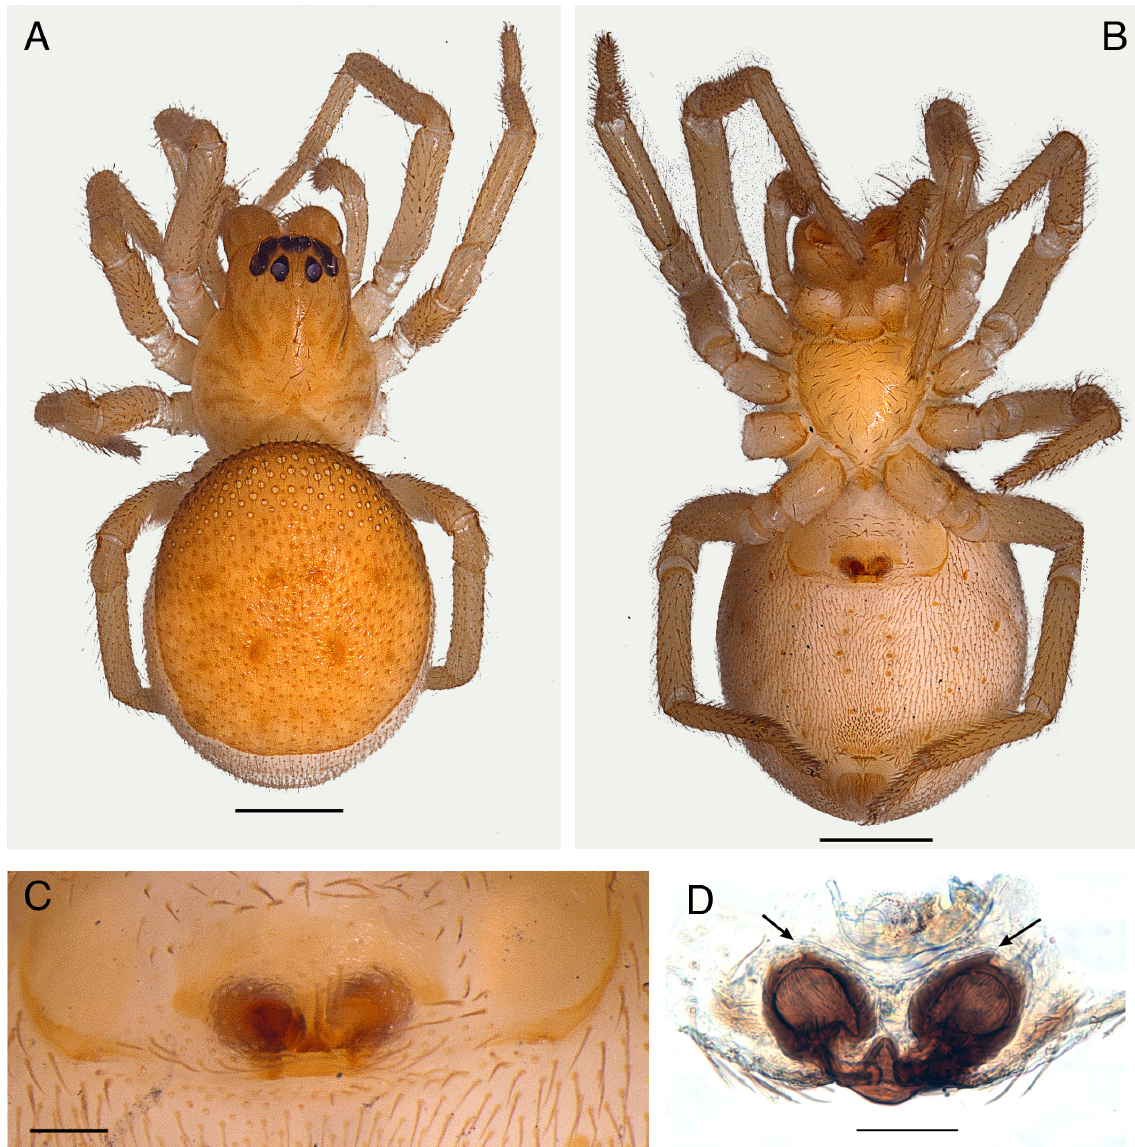
Fig. 6. Chumma lesotho sp. nov., holotype, ♀. A . Habitus, dorsal view. B . As preceding, ventral view. C . Epigyne, ventral view. D . Epigyne, cleared, dorsal view. Scale bars: A–B = 0.5 mm; C–D = 0.2 mm. Arrows indicate anterior protuberance on